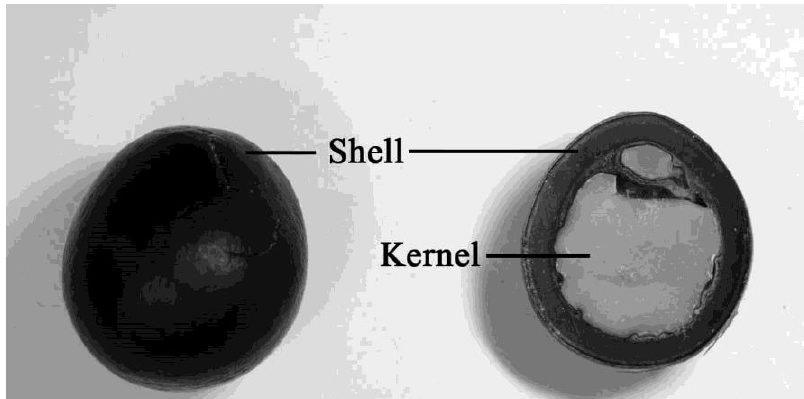
Figure 1. Pictures of the intact seed, seed shell and the kernel of the Sapindus mukorossi